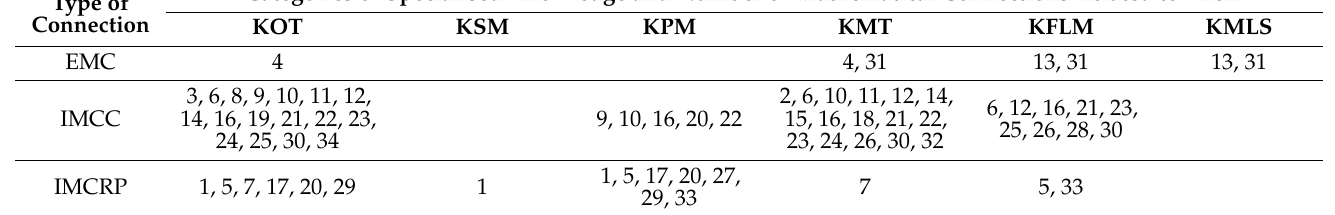
Table 5. Relationship between the establishment of mathematical connections (CC) and types of knowledge mobilised by the teacher in study 2.